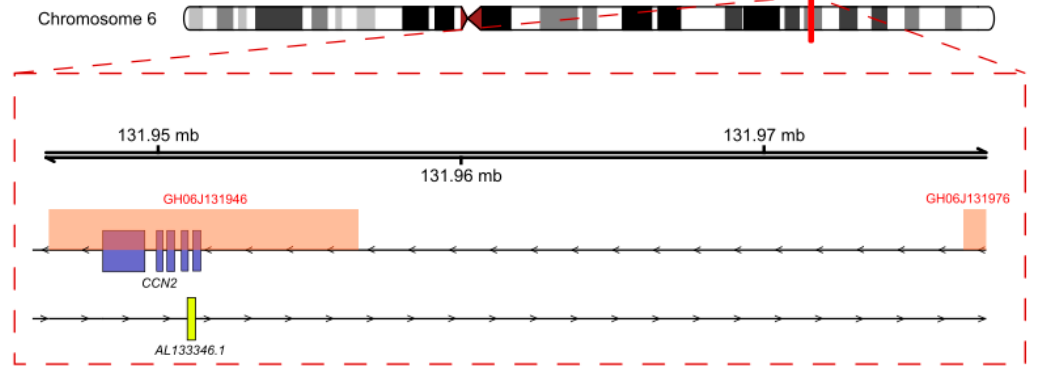
Figure 4. Genomic location of AL133346.1 / CCN2 in chromosome 6. The box with dashed stripes represents a zoom-in of the locus. All CCN2 exons are shown while only the first AL133346.1 exon is included. GH06J131946 and GH06J131976 regulatory regions are represented by red boxes.